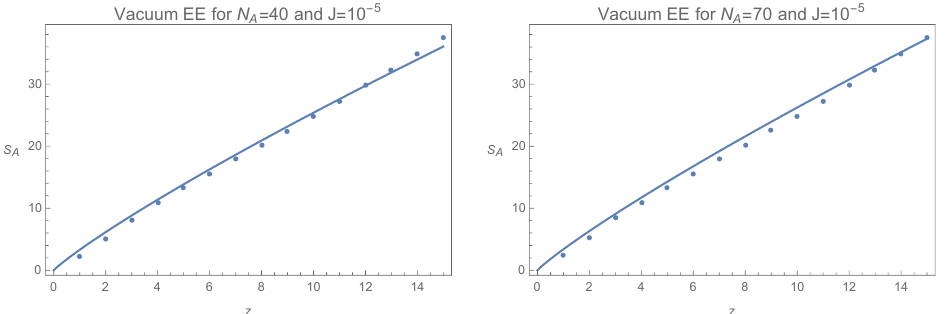
= 40,70 and J = 10 − 5 and plotted the A = 1.996 for the N = 40 case A 0